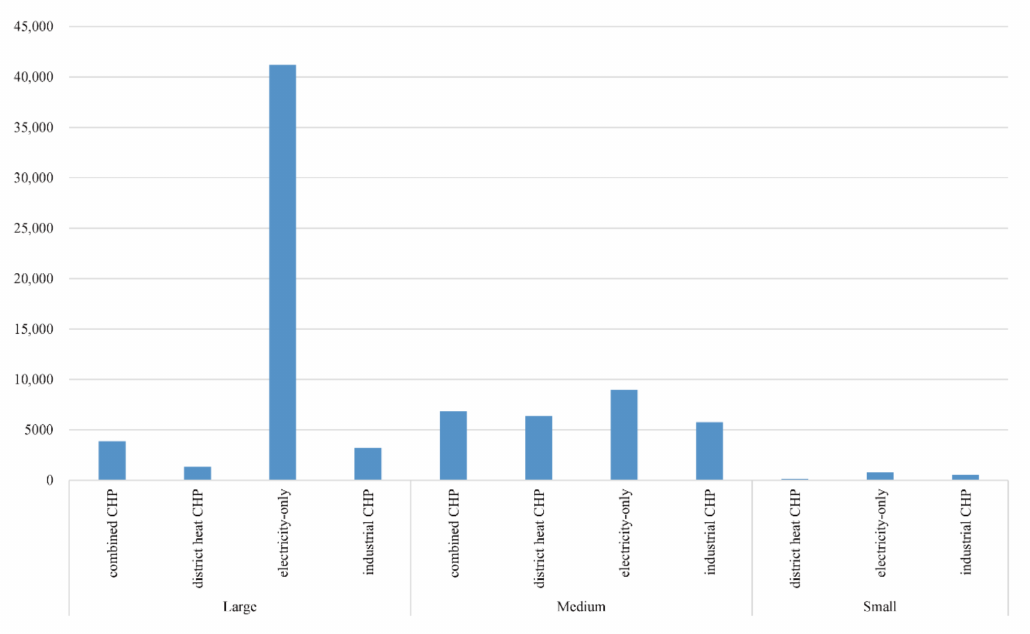
Figure 6. Unit usage under different categories.